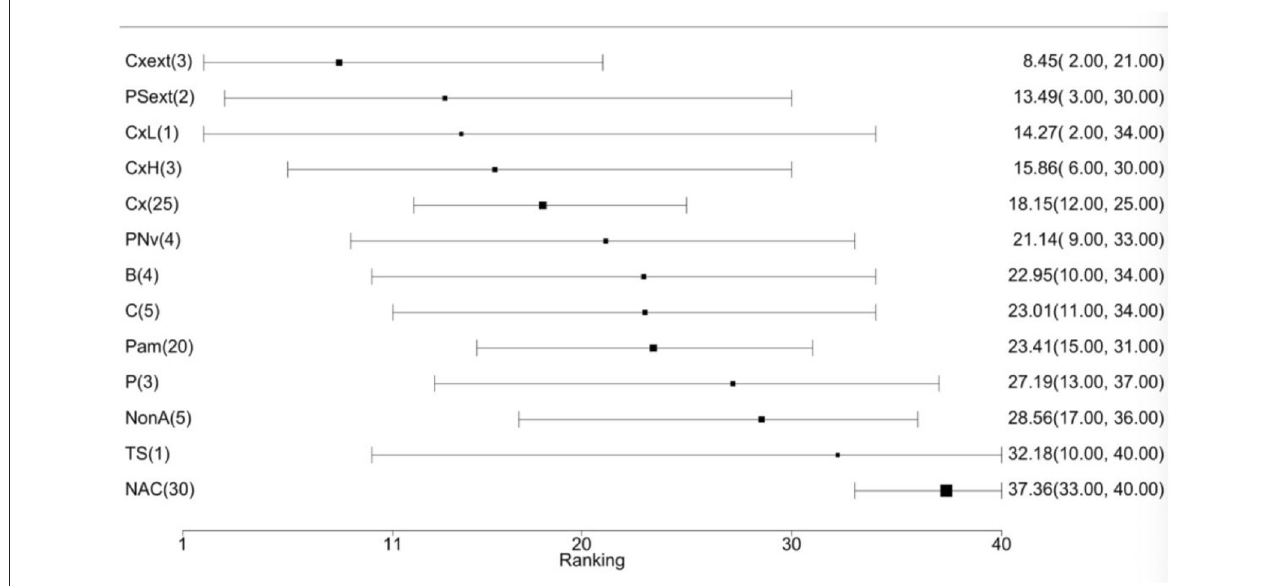
FIGURE 4 | Forest plot of mean treatment rank for currently labeled antimicrobial treatment protocols in Canada and the United States to cure existing IMI during the dry period. The black squares indicate the mean rank of each treatment and its size reflects the precision (i.e., 1/variance) of the estimate. The values are reported as mean treatment rank with corresponding 95% CI . The number of treatment comparisons is provided in parentheses beside the treatment names. The treatment acronyms are as follows: cloxacillin–extended therapy (Cxext), penicillin/streptomycin–extended therapy (PSext), cloxacillin–low dosage (CxL), cloxacillin–high dosage (CxH), cloxacillin (Cx), penicillin/novobiocin (PNv), ceftiofur (B), cefapyrin (C), penicillin/aminoglycoside combinations (Pam), penicillin (P), non-antimicrobial treatment (NonA), teat sealant (TS), non-active control (NAC) ( Table 2